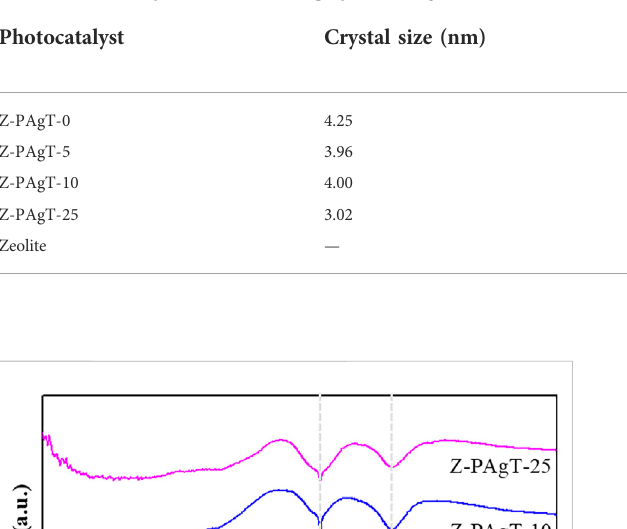
TABLE 1 Structure parameters of Z-PAgT photocatalysts with different zeolite wt%.